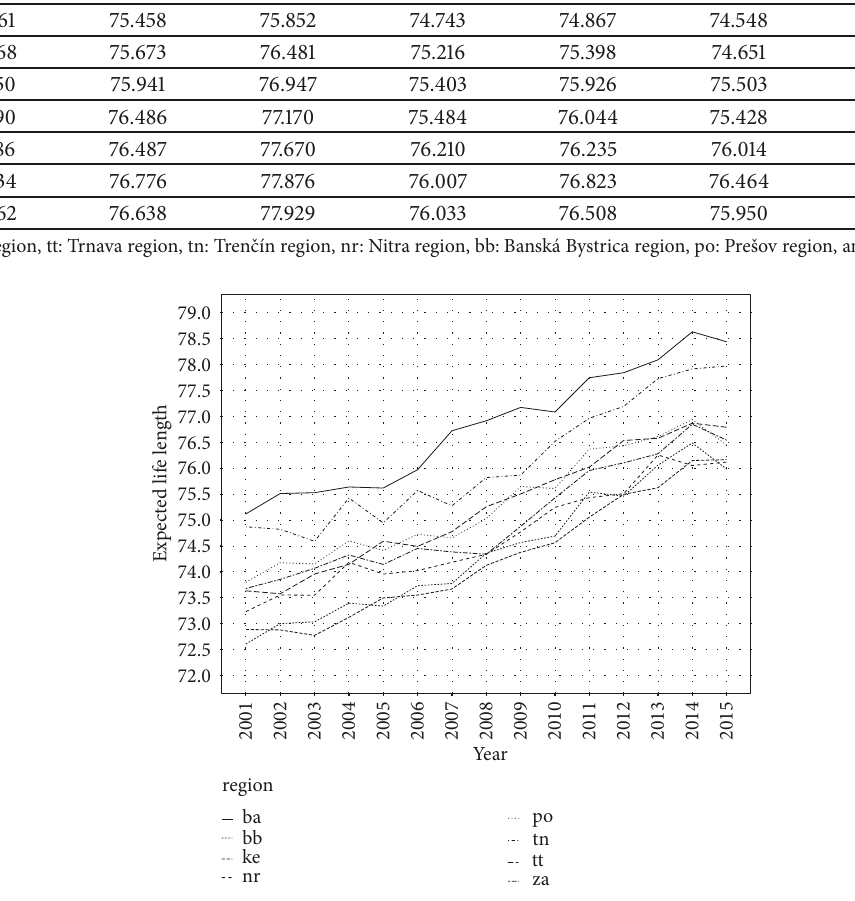
Figure 2: Expected life length in Slovak regions eliminating Alzheimer’s